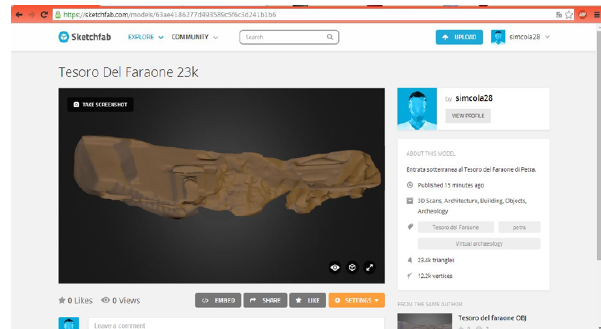
Figure 9. The visualization of the 3D model on the web browser, created with Sketch